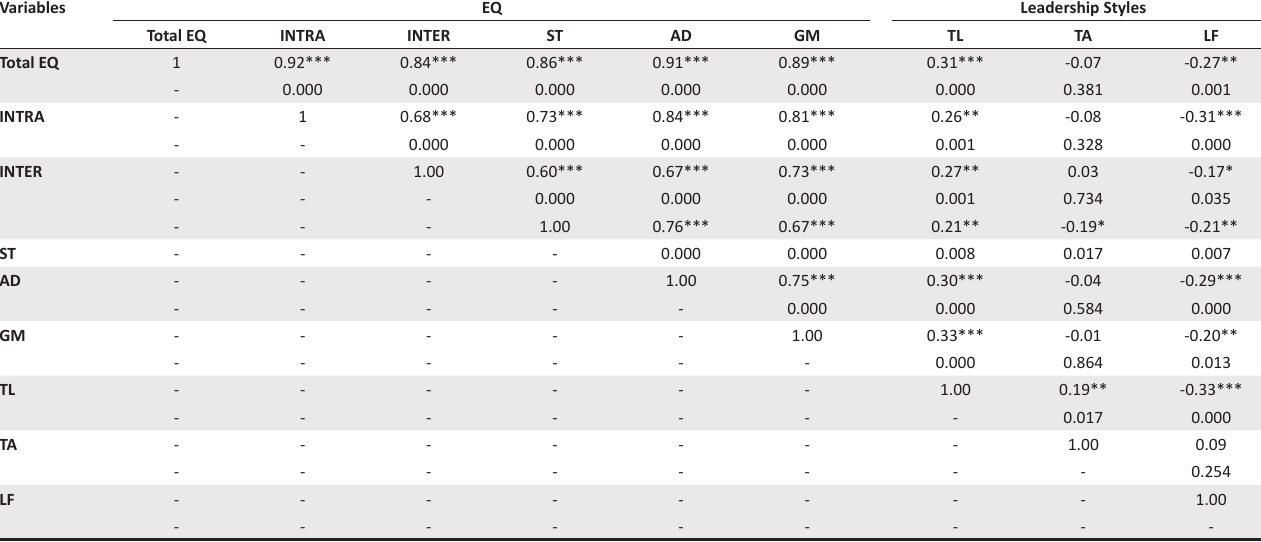
TABLE 3: Intercorrelations between emotional quotient and constructs with leadership styles.